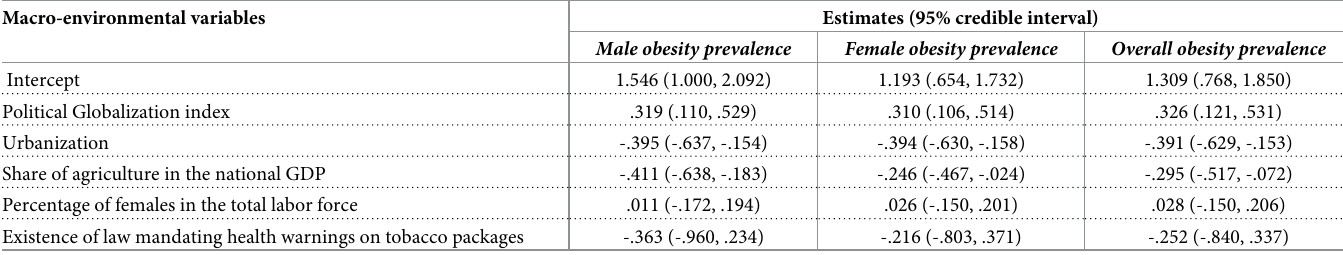
Table 2. Moderating effects of macro-environmental variables on the national income elasticity of population obesity prevalence 1 .